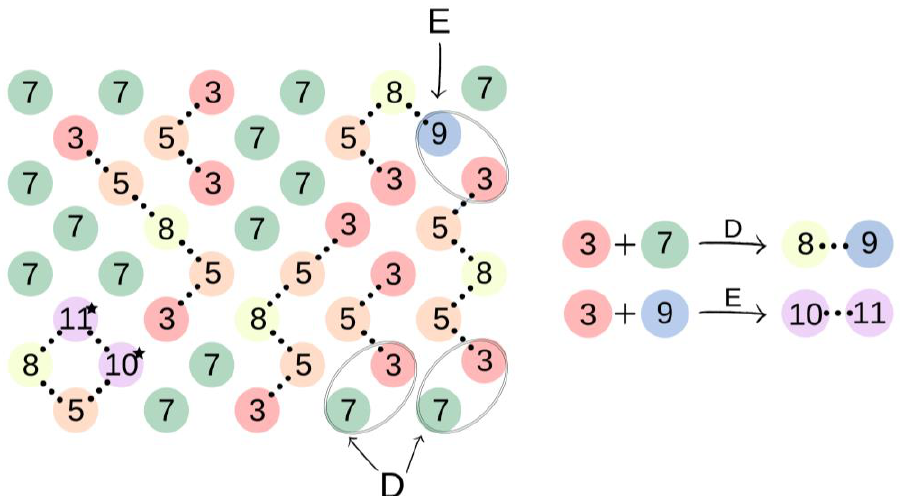
Figure 5. An illustration of the process of oligo(decamethylene carbonate) synthesis. In the case of elements (10) and (11) originated from that same polymeric chain the polymeric ring is formed, which was illustrated with * after elements numbers.